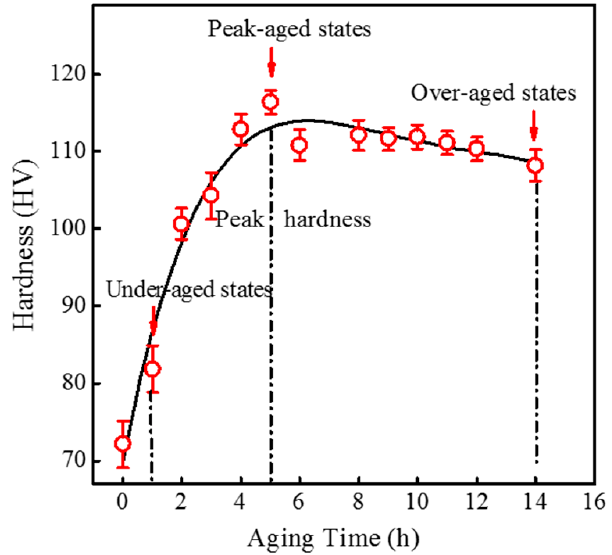
Figure 2. Variation in hardness as a function of ageing time for samples aged at 180 ◦ C after solution heat treatment at 550 ◦ C for 1 h.